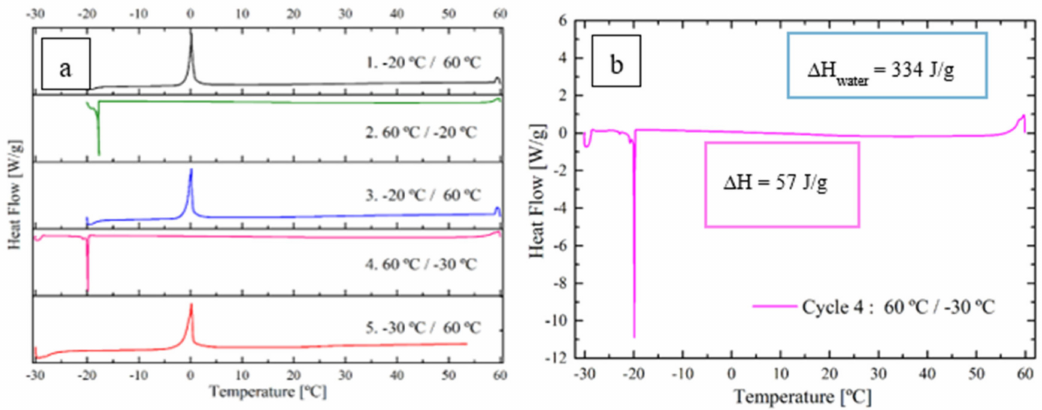
Figure 6. ( a ) Curves of the wet DSC experiment for PEGMA film (1.5 mg) with 1 mg of water. ( b ) Cycle 4 of the DSC experiment with the melt endotherm